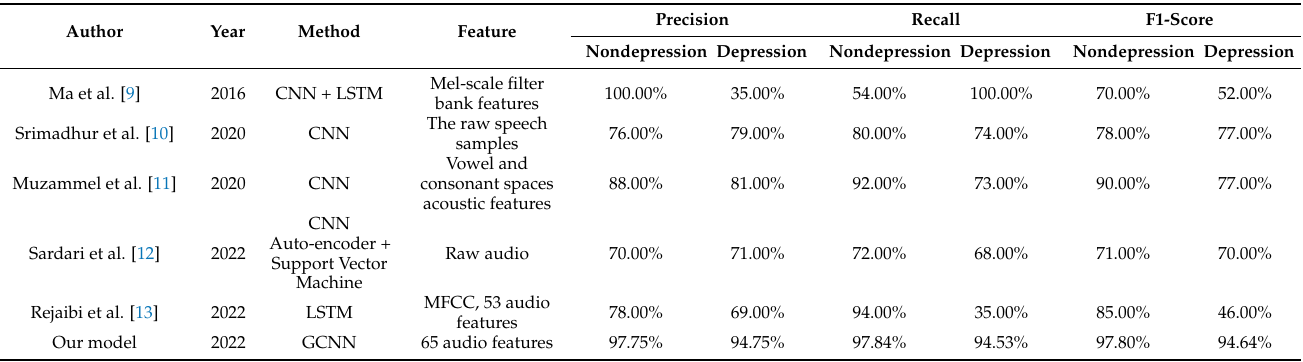
Table 13. Comparison of the classification accuracy between our model and the existing methods in the binary classification under Setting 1.